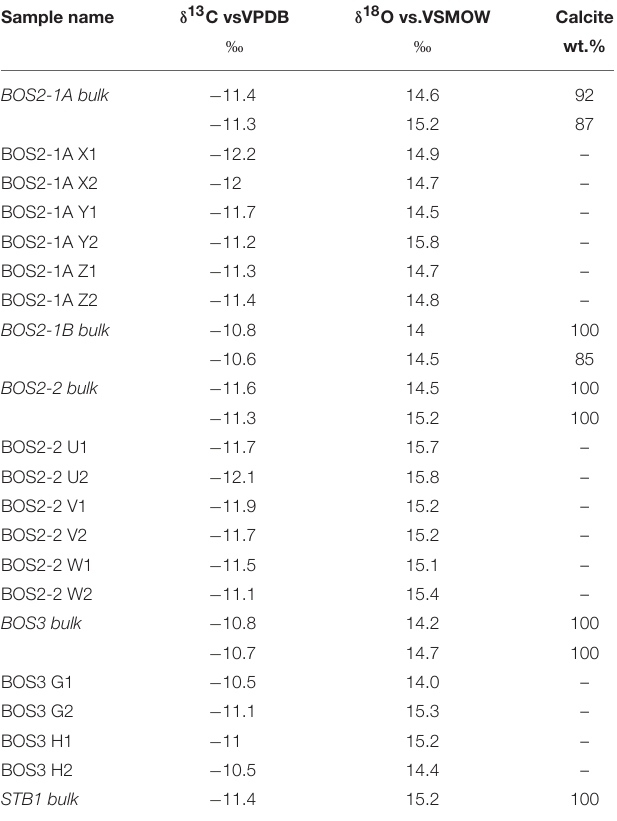
TABLE 3 | Bulk and microsampling stable isotope